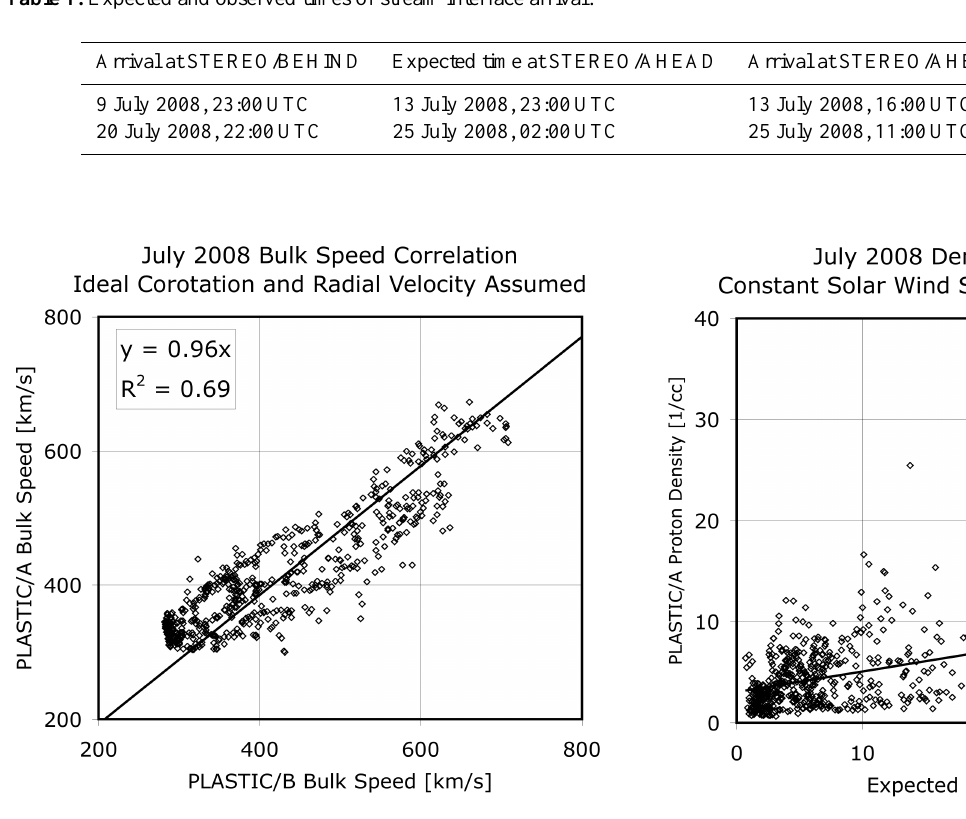
Solar wind bulk speed correlation between PLAS- TIC/AHEAD and PLASTIC/BEHIND for July 2008.